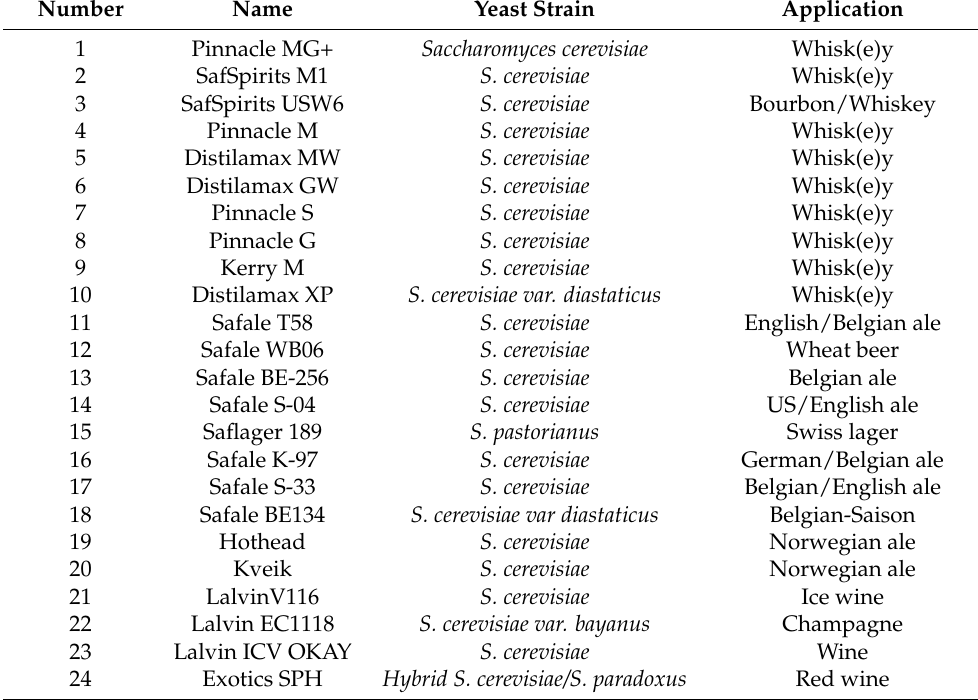
Table 1. Yeast strains used in this study.